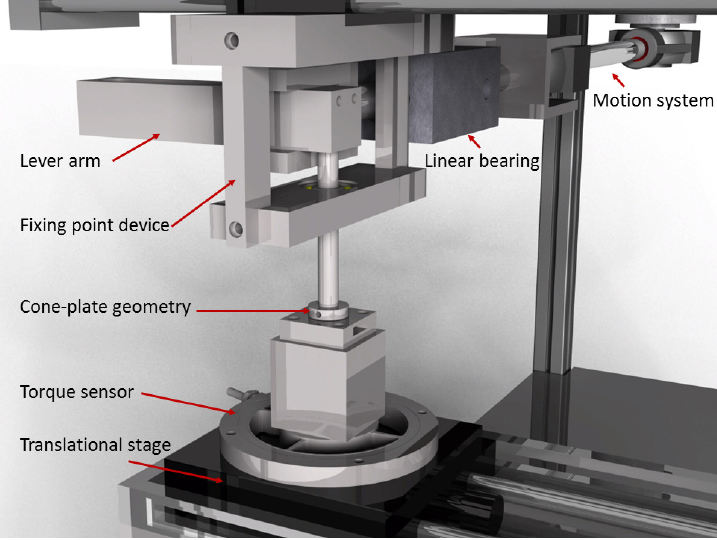
Figure 1. Rheometer and motion mechanism drawn in Catia V5 ® .